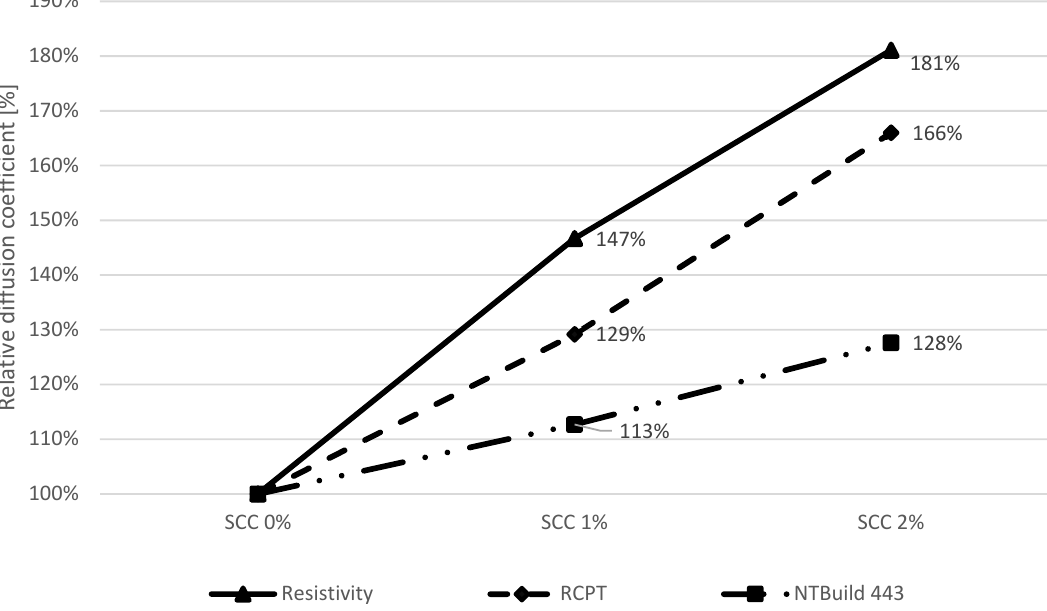
Figure 7. Percentile differences of the diffusion coefficient of the SCC 1% and 2% mixtures compared to mixture SCC 0%.